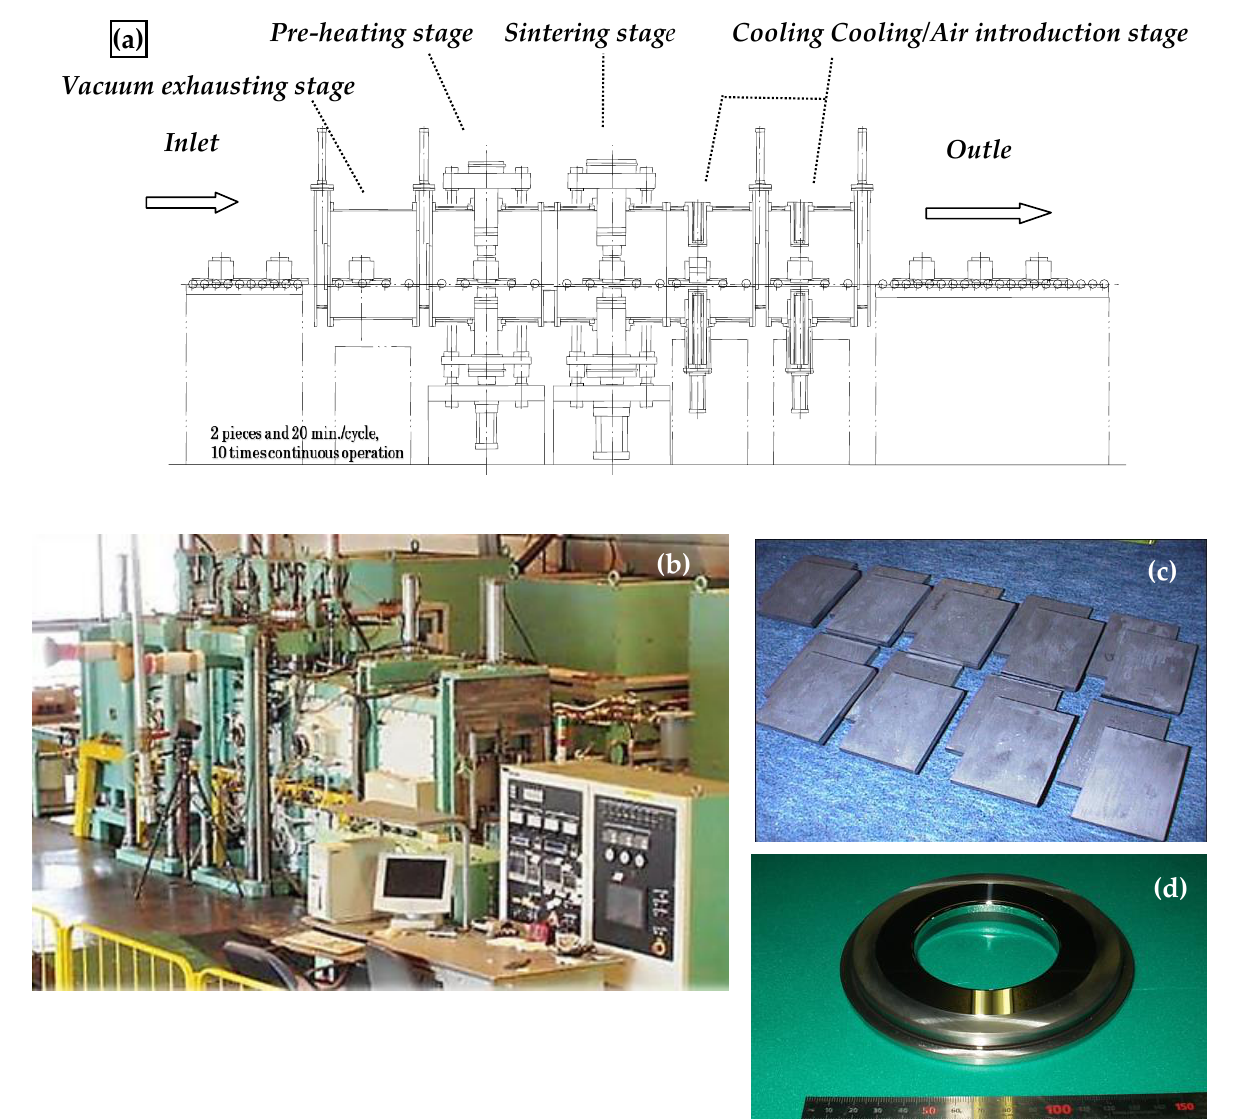
Figure 44. System configuration and outside view of Tunnel-type SPS production system: ( a ) Automatic continuous SPS System configuration; ( b ) Outside view of full-Tunnel-type SPS production system; ( c ) Large-sized square shape 100 × 70 mm WC/Co hard-alloy SPSed compacts fabricated in 10 times continuous operation; ( d ) example of WC/Co SPSed material used drawing die for aluminum can manufacturing (finished component by mechanical cutting, milling and grinding).